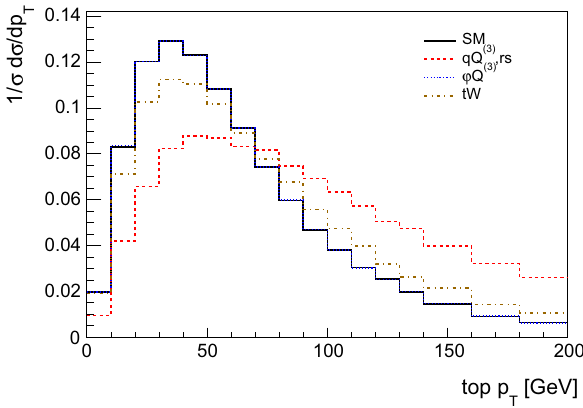
Fig. 2 The normalised leading order parton-level differential cross section as a function of the transverse momentum of the top quark. The expectation of the SM together with the interference effects of the three effective operators of interest are